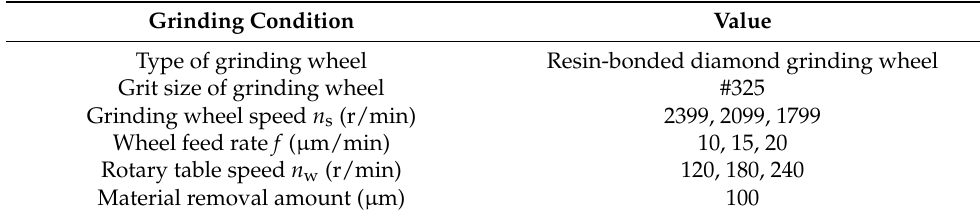
Table 2. Grinding experiment parameters for PEEK.